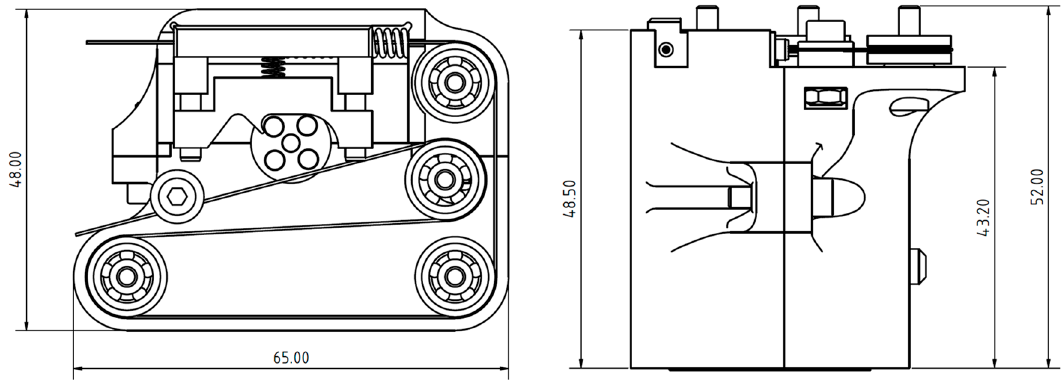
Figure 8. Dimensions of the developed actuator (all units given in mm).